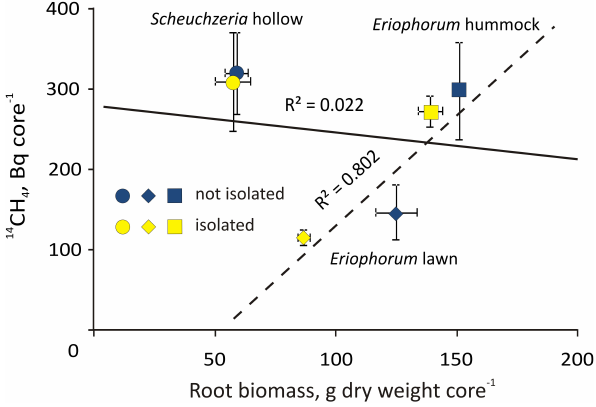
Fig. 5. Total amount of labeled 14 CH 4 emitted during the period of measurements vs. root biomass of vascular plants from isolated and not isolated mesocosms with E . vaginatum and S. palustris of three microform types. Solid line linear regression of all data pre- sented; dashed line is a linear regression of isolated and not isolated E . vaginatum from hummocks and lawns alone. Errors are standard errors of measurement ( n =